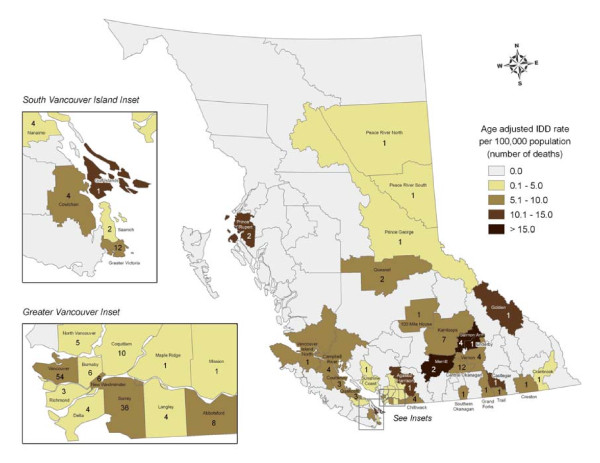
Illicit Drug Deaths in British Columbia by local health area, 2006 (n = 223). Illicit Drug Deaths (IDD) are mapped by place of injury. Age-adjusted rates of IDD in rural local health areas with small number of IDD should be interpreted with caution due to unstable rates.